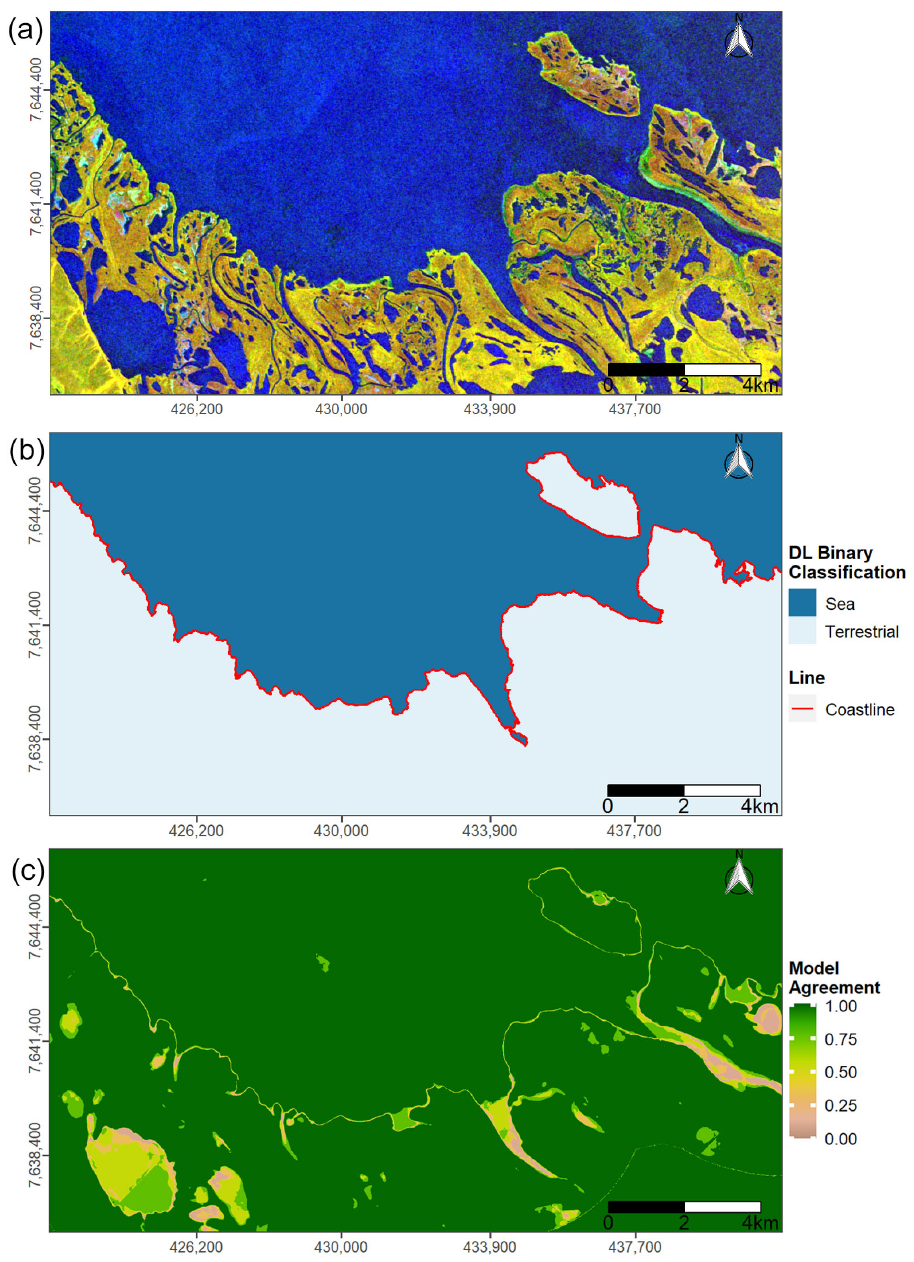
Figure 7. ( a ) Sentinel-1 (S1) pseudo Red Green Blue (RGB) composite covering the temporal win- dow June–September 2020; ( b ) Mode image of the nine binary classifications from different U-Net architectures. The two classes represent terrestrial areas, including inland rivers and lakes (light-blue color) and sea areas (dark-blue color); ( c ) Agreement between the nine different classifications from different U-Net models. All images cover a section along Shoalwater Bay in